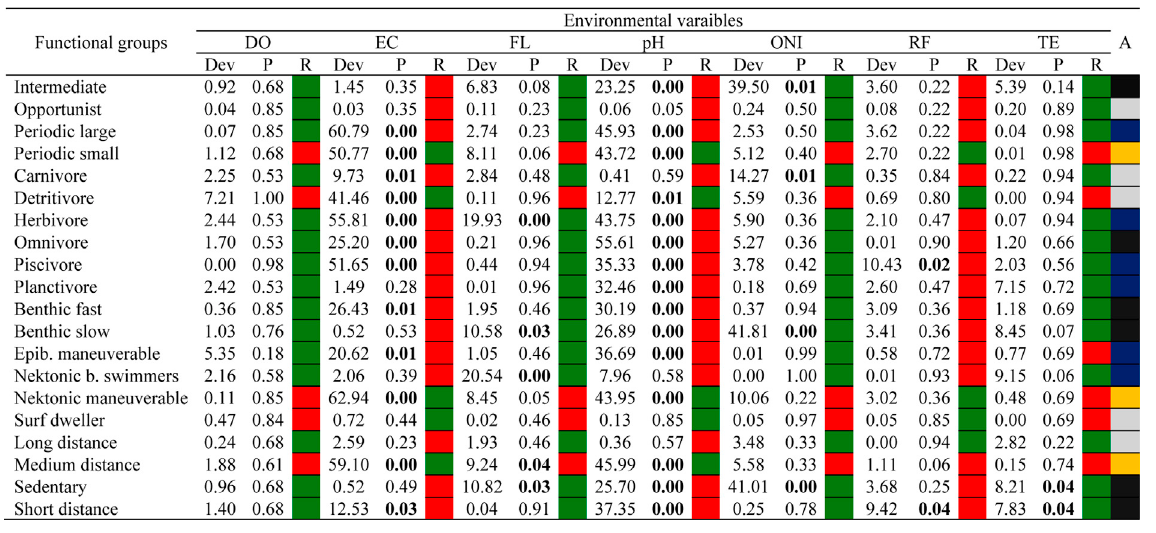
TABLE 3 Summary of GLM for the effects of environmental variables and periods on the functional structure of fi sh larvae assemblages in the Lower Amazon.DO = Dissolved Oxygen, EC = Electrical Conductivity, FL = Flow, pH = Hydrogenonic Potential,ONI = Oceanic Niño Index, RF = Rainfall, TE = Temperature, A = association with the neutral period (color blue), El Niño (color black) and La Niña (color yellow), and absence of association signi fi cativewith periods(color gray).R= type of positive (color green) ornegative(color red) relationship withthe environmentalvariable. Values in bold indicate signi fi cance (p <